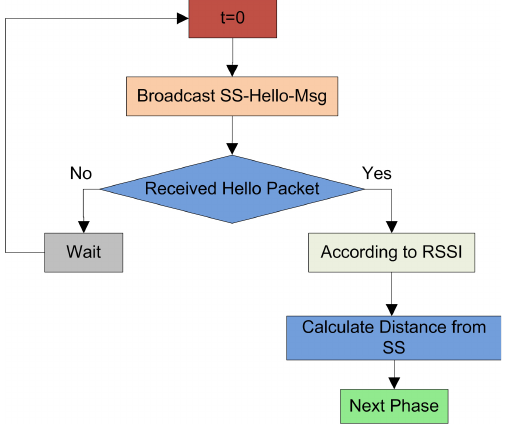
Figure 2. The flowchart of initialization of the proposed framework.